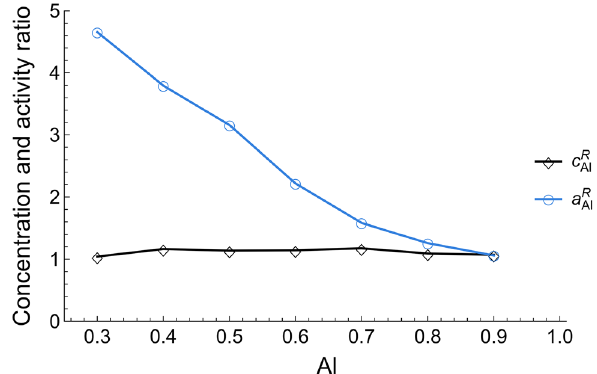
Figure 8. Activity and concentration ratios of Al–Ni alloys.